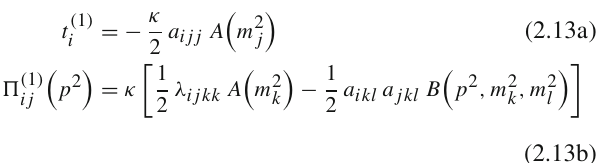
The one-particle irreducible one-loop contributions to the one- and two-point functions (see Fig. 1) of this toy model are given